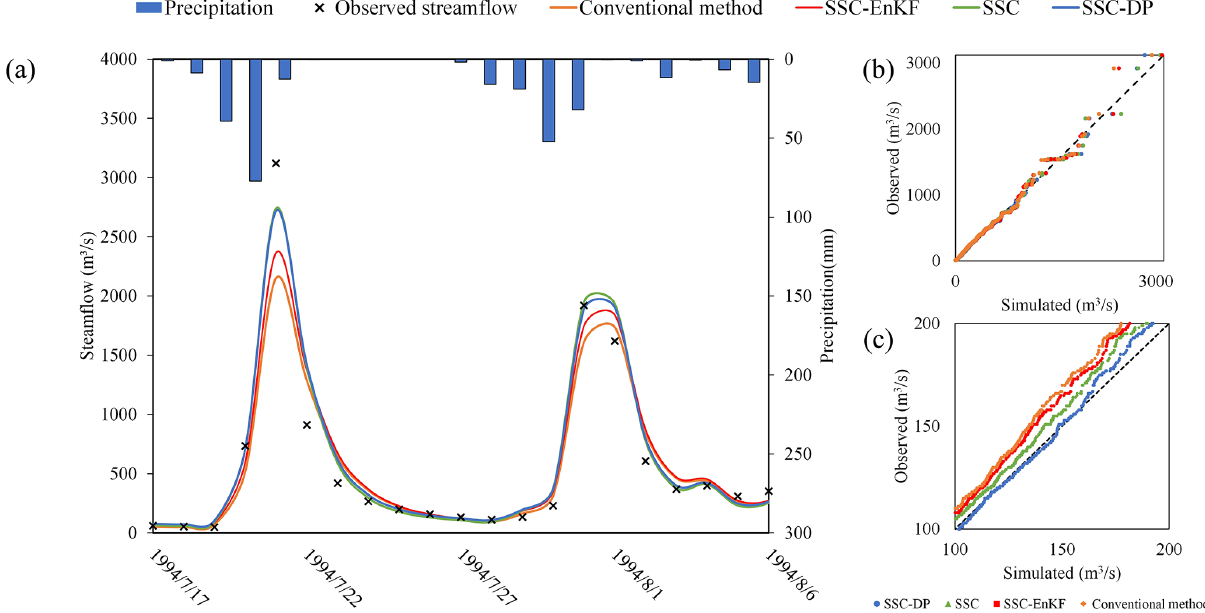
Figure 16. The simulated and observed streamflow using the conventional method, SSC-EnKF, SSC, and SSC-DP for the Xun River basin. (a) Streamflow simulation hydrograph. (b) The quantile–quantile plot for all streamflow. (c) The quantile–quantile plot for streamflow ranging from 100 to 200m 3 s − 1 .